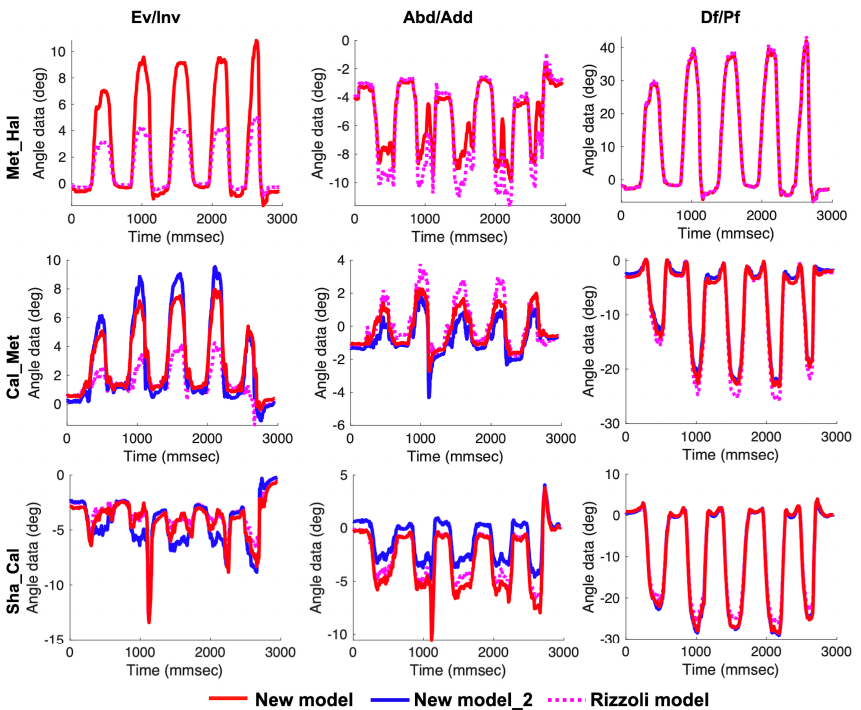
Figure 9. Left to right, the temporal patterns of rotation in the frontal, transverse, and sagittal planes during the calf raise. New model (red solid line), New model_2 (blue solid line), and the Rizzoli model (pink dot line) are shown. First to third row in order, the three joint angles (Met_Hal, Cal_Met, and Sha_Cal) are shown.